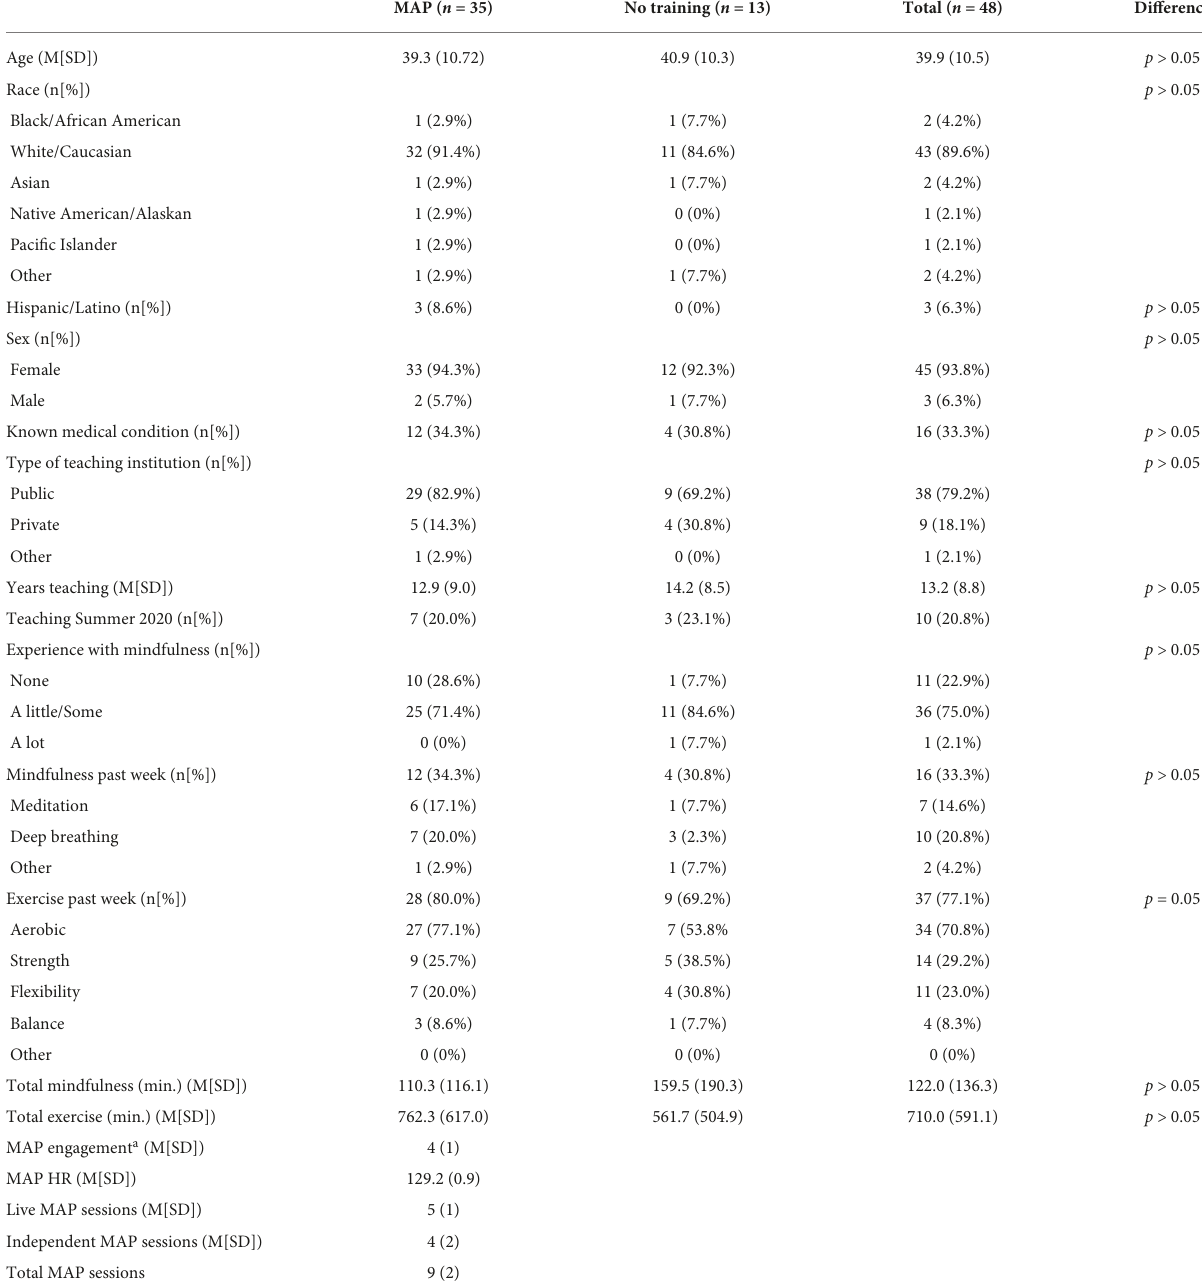
TABLE 1 Sample characteristics: treatment-adherent MAP training group vs. no training group. MAP ( n =